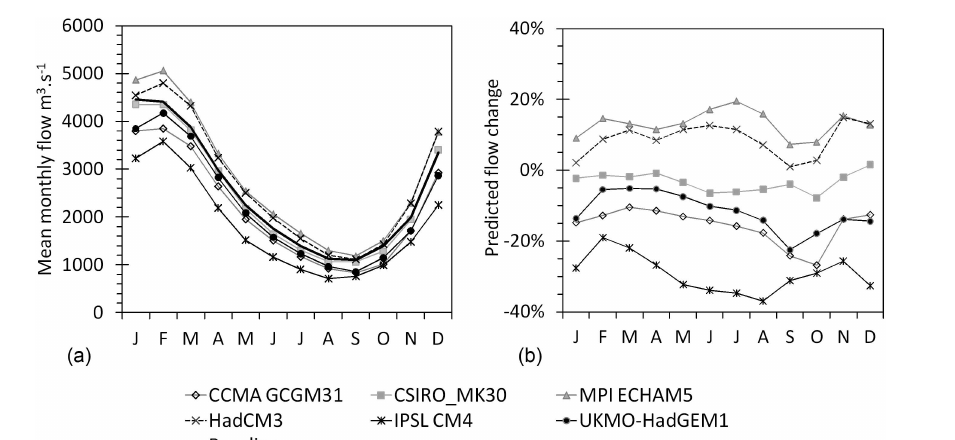
Fig. 7. Projected changes in mean monthly river flow under the A1b SRES emissions scenario from six priority GCMs in the Rio Grande basin (a) and relative to 584 the detrended 1961–1990 baseline or control run (b) .